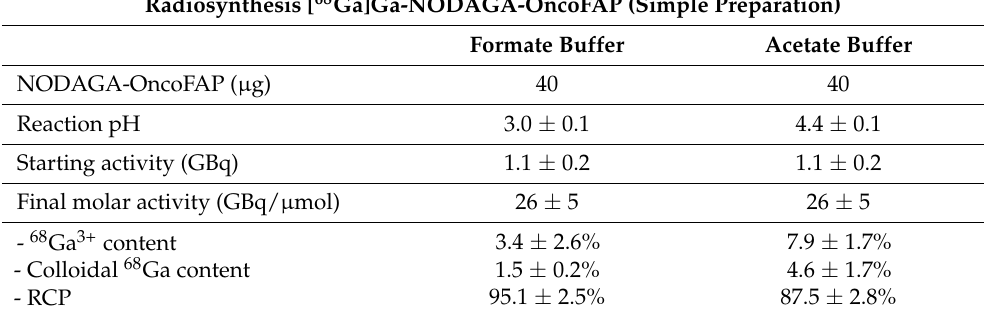
Table 5. Average value obtained for the synthesis of [ 68 Ga]Ga-NODAGA-OncoFAP. Radiosynthesis [ 68 Ga]Ga-NODAGA-OncoFAP (Simple Preparation)